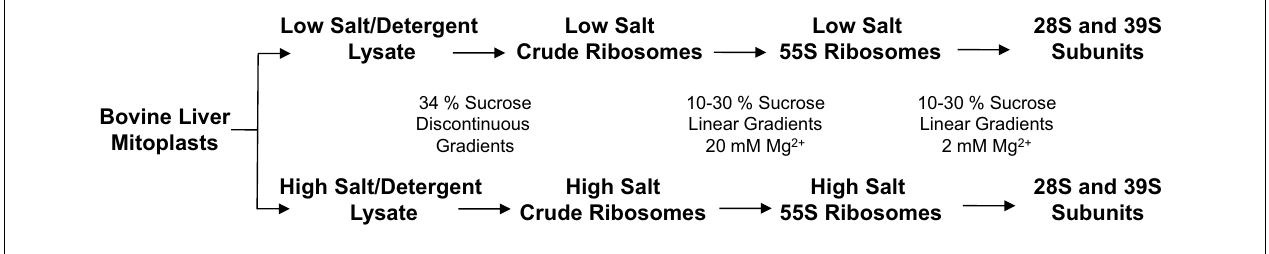
FIGURE 1 | Experimental scheme for the purification of mitochondrial ribosomes and 28S and 39S subunits. To obtain purified 55S ribosomes and 28S and 39S subunits using sequential linear sucrose gradients, bovine mitochondrial lysates